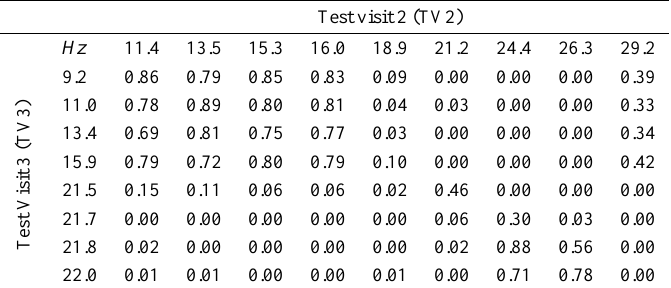
Table 3 Matrix of MAC values arising from a comparison of first floor slab modes from